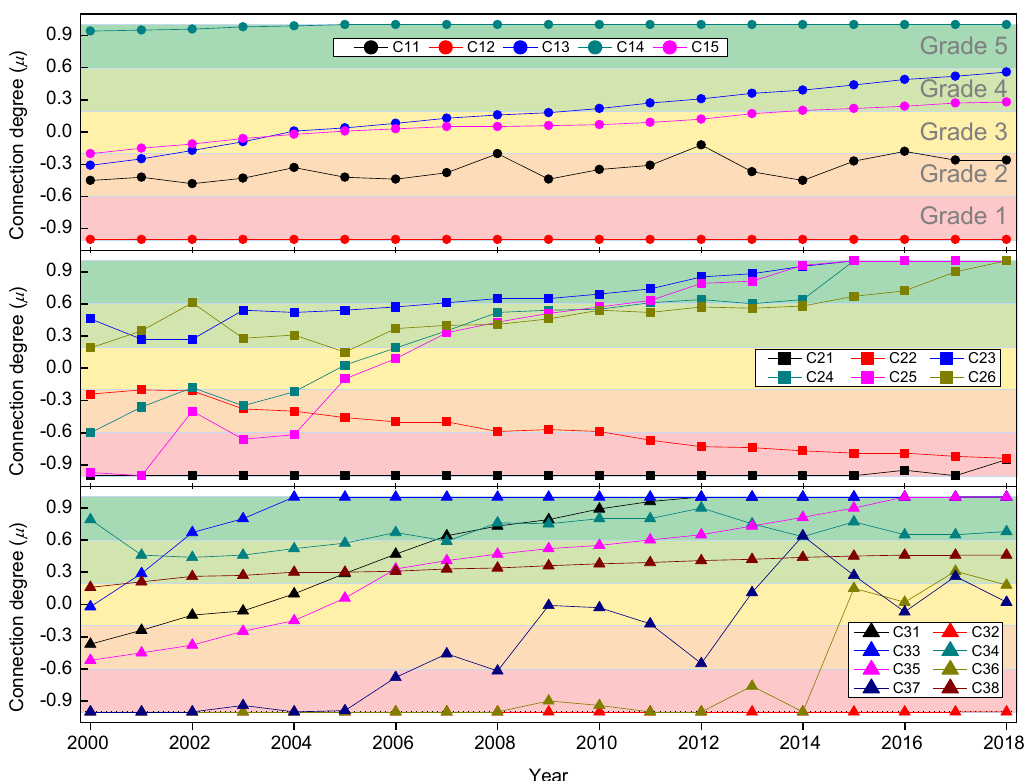
Figure 4. Variations in the connection degrees for indicators C11–C38 and their grades.